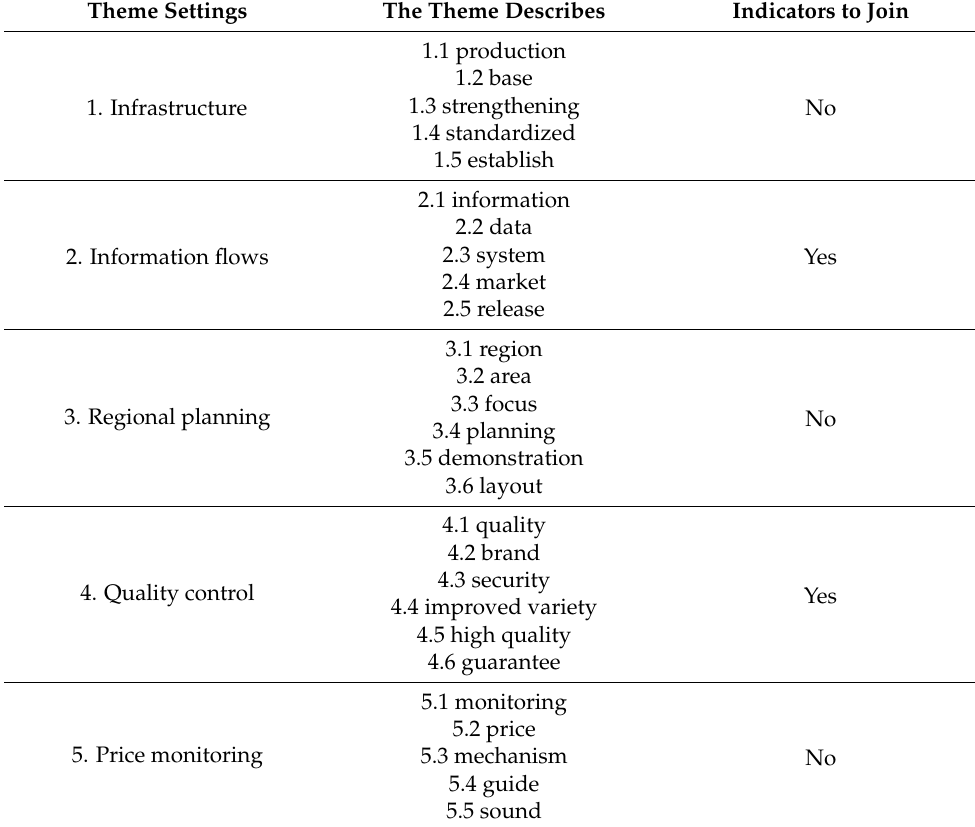
Table 3. LDA Topic Modeling